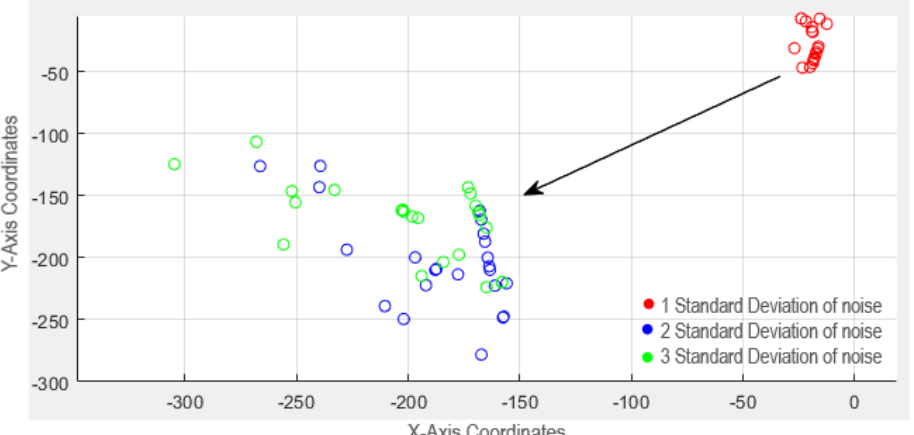
Figure 11. Eigenvalue estimation in eigenvalue space with